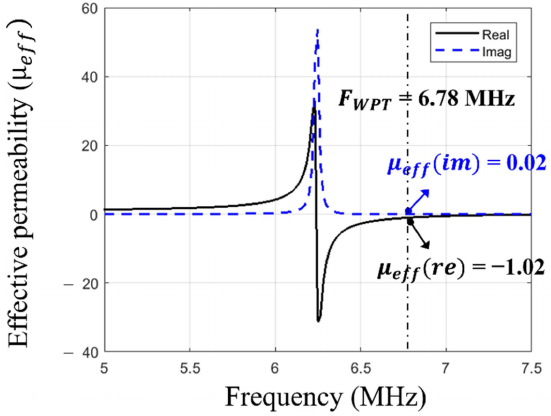
Figure 6. Simulated effective magnetic permeability of the MS